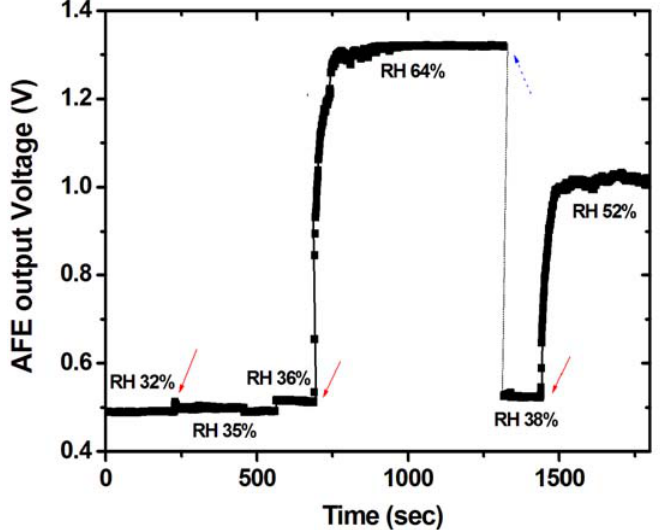
Figure 7. The response time test result. The initial relative humidity (RH) of experiment is about 36%. Then injecting the water vapor (ON state), the relative humidity becomes 64%. After about 600 sec, to remove the vapor (OFF state) the voltage signal falls to its initial value rapidly in room